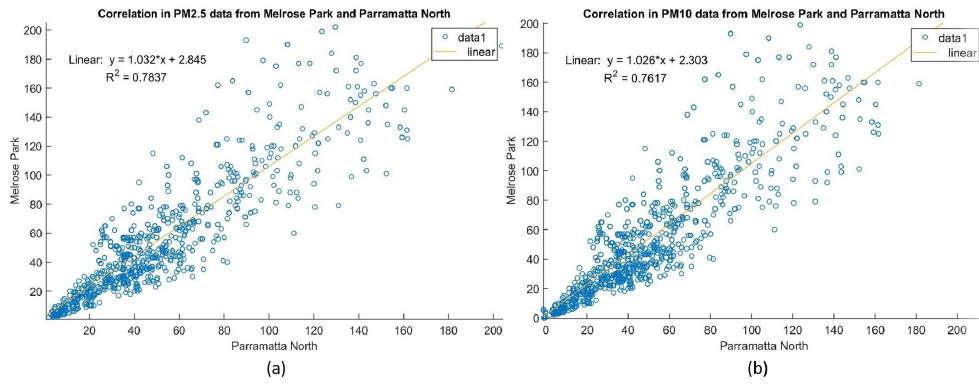
Figure 4. Scatter plots: ( a ) PM2.5 and ( b ) PM10 collected at the site and the station.